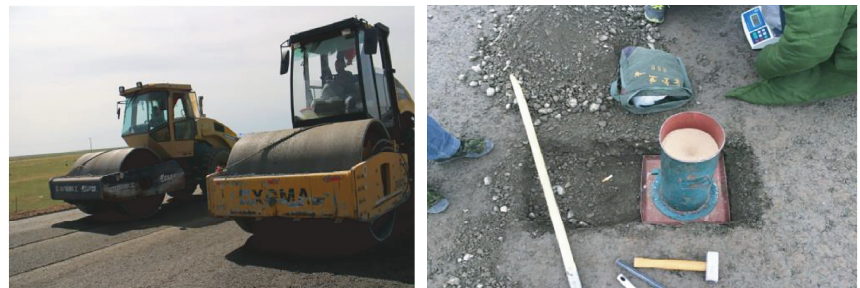
Figure 7: Base compacting and compaction quality detection.